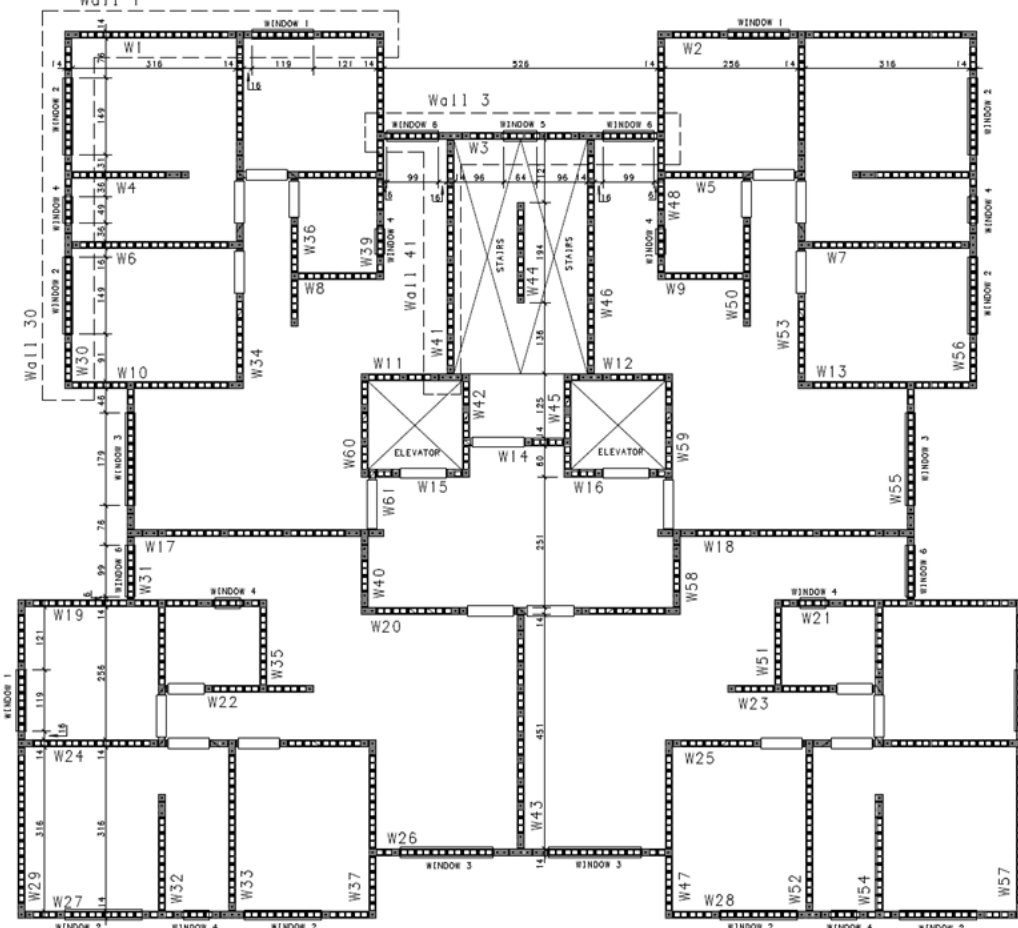
Figure 5. Wall layout, highlighting the walls under study. Adapted: Medeiros [5].